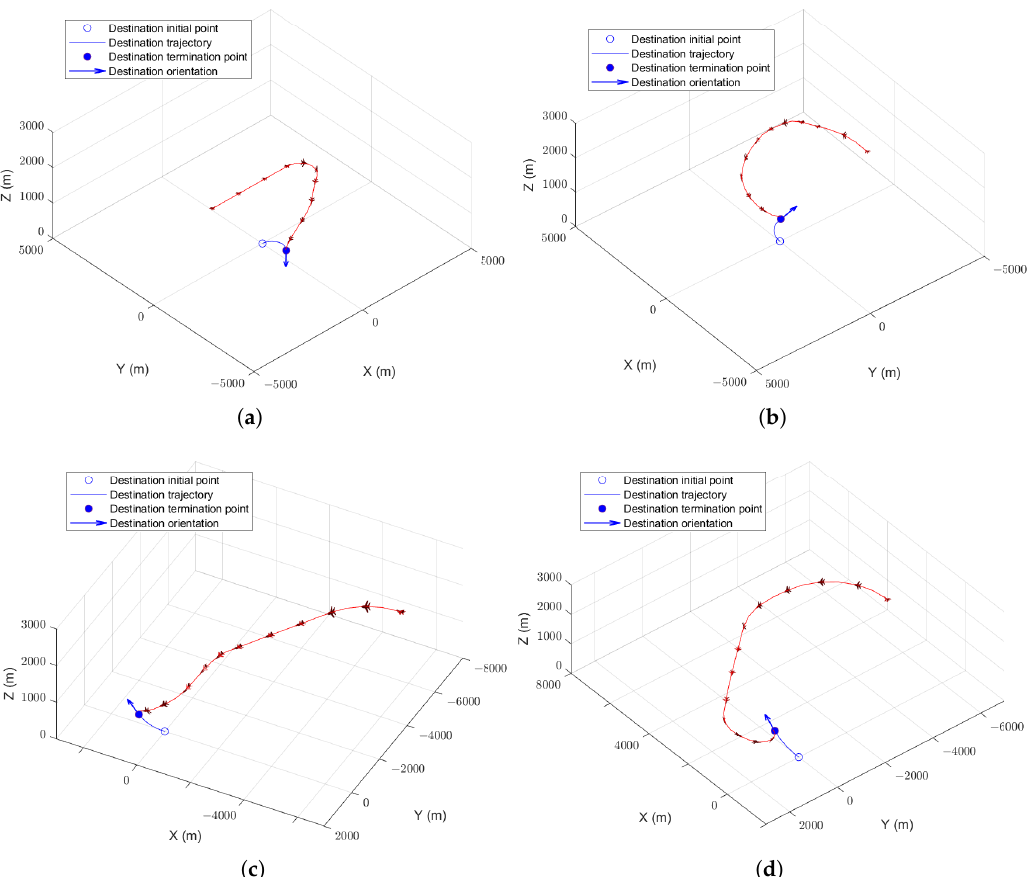
Figure 10. Trajectories in curved-motion destination scenario: destination turning radius of ( a ) 500 m, ( b ) 1000 m, ( c ) 2000 m and ( d ) 5000